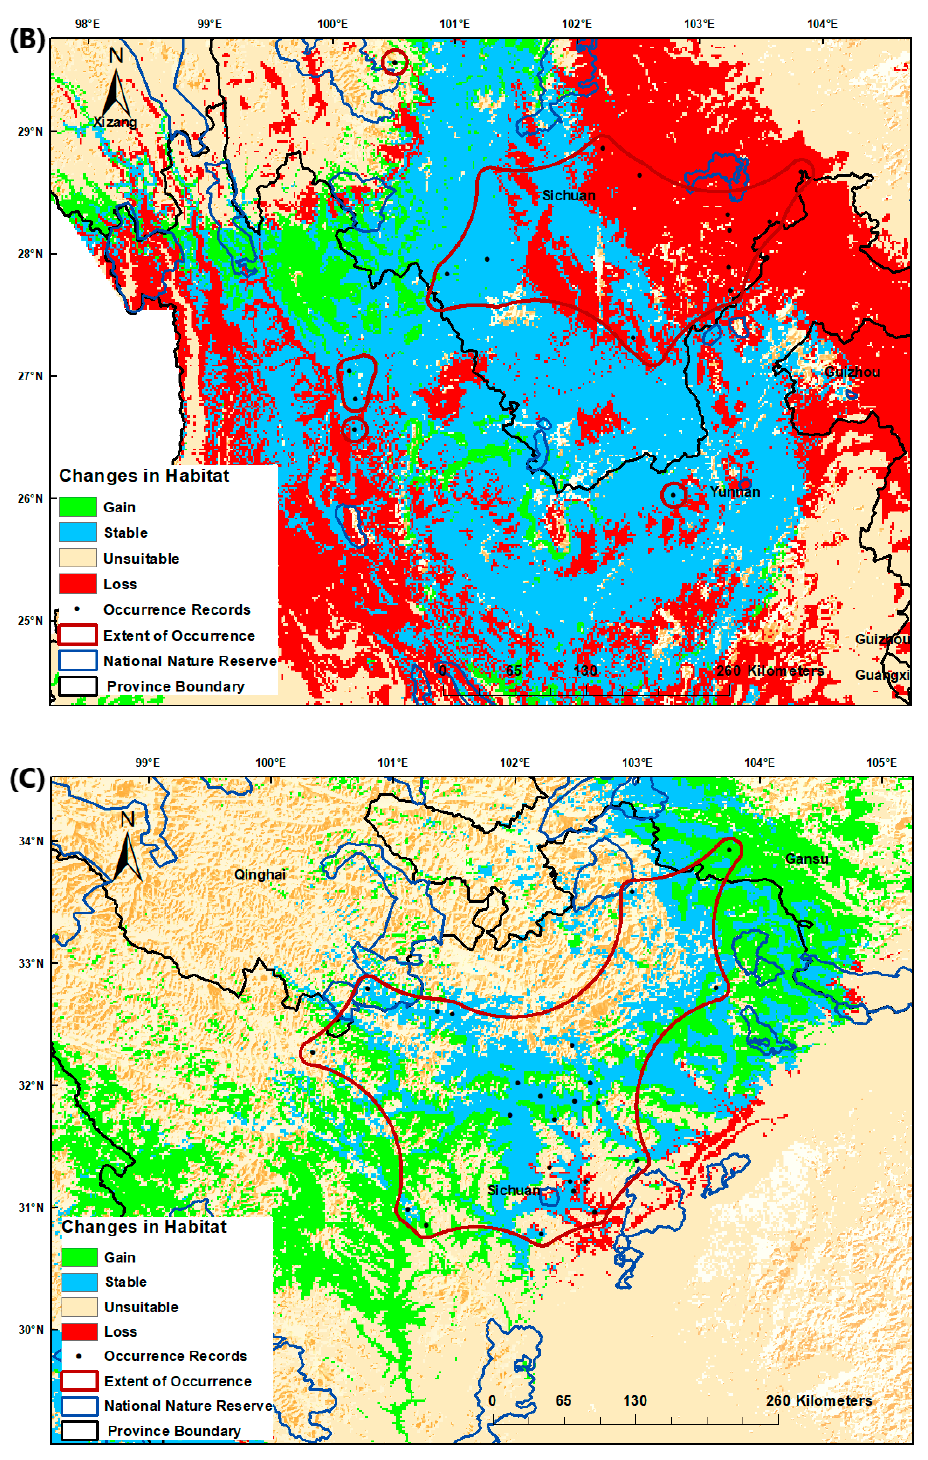
Figure 2. Potential habitat suitability under future RCP4.5 climate scenario for the ( A ) Juniperus tibetica , ( B ) Juniperus pingii var. pingii , and ( C ) Juniperus komarovii species based on threshold-independent metrics.